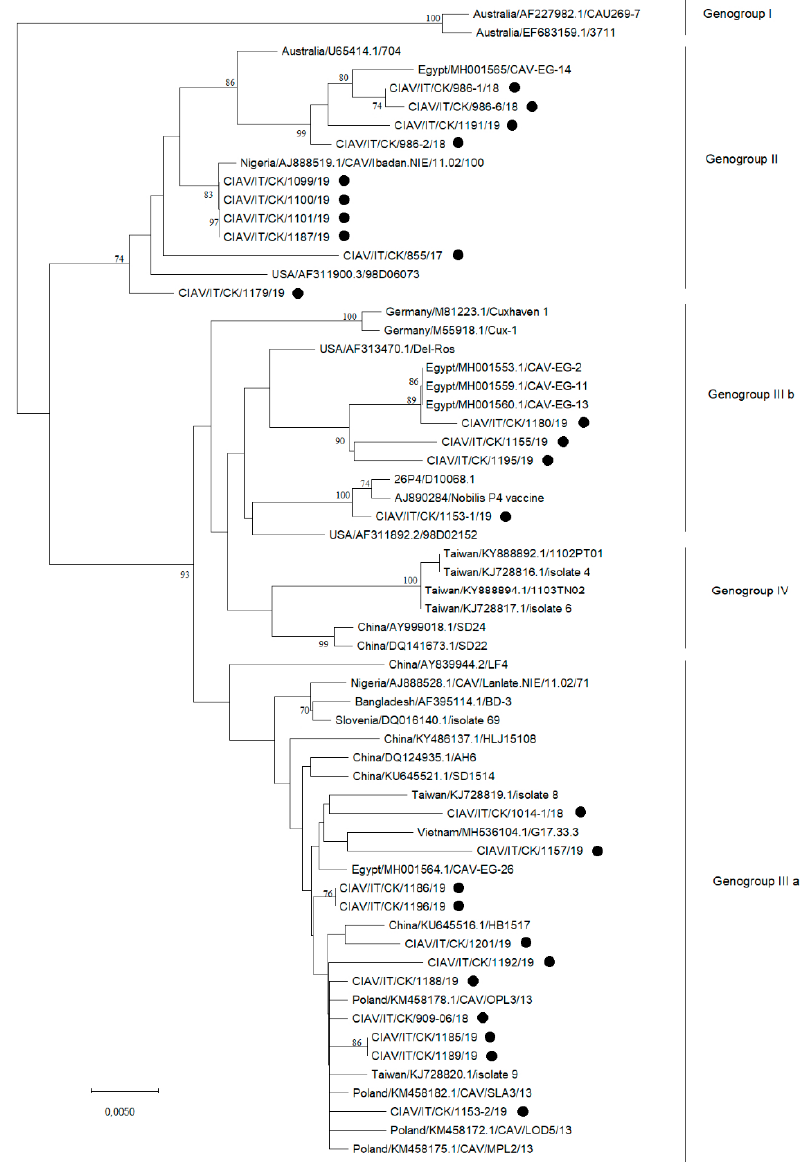
Figure 2. Phylogenetic tree based on the partial VP1 nucleotide sequence of twenty-five Italian CIAV strains (marked with a black circle) and reference CIAV strains retrieved from GenBank. Genogroup classification is also indicated on the right of the tree. Only bootstrap values ≥ 70 are reported. The tree is drawn to scale, with branch lengths in the same units as those of the evolutionary distances used to infer the phylogenetic tree.